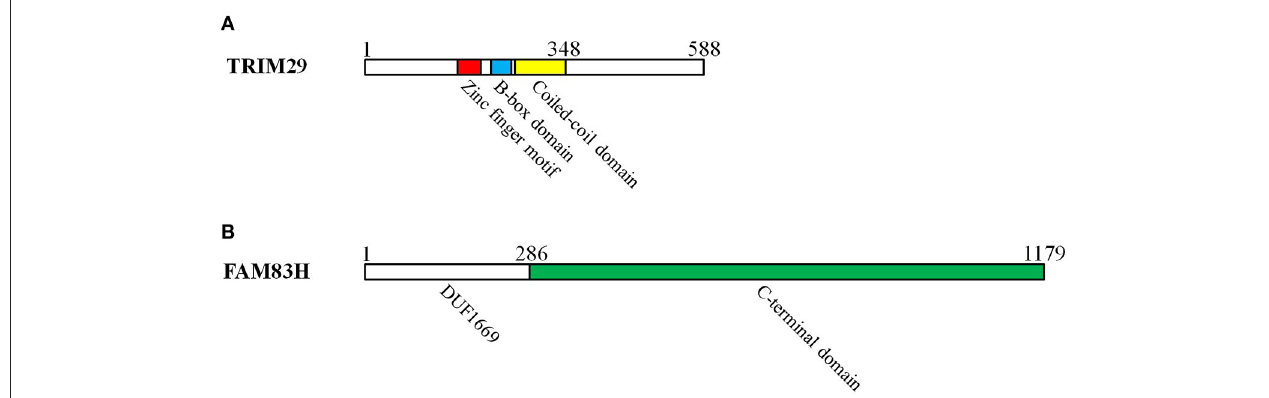
FIGURE 1 | The domains of TRIM29 and FAM83H interact with keratin in cutaneous squamous cell carcinoma. (A) TRIM29 is pertinent to RING-less group of TRIM family proteins, which consist of four zinc finger motifs in the B-box domain and a coiled-coil domain. The zinc finger, B-box, coiled-coil, and C-terminal domains of TRIM29 are all essential for the construction of the TRIM29–keratin–FAM83H complex. (B) FAM83 members have a common N-terminal domain (domain unknown function 1669: DUF1669) and a C-terminal domain. The C-terminal domain of FAM83H is required for the formation of the TRIM29–keratin–FAM83H